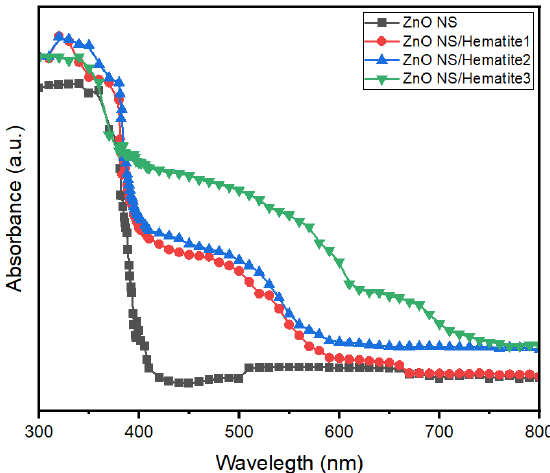
Figure 3. UV-visible absorbance of prepared nanostructures and heterostructures.